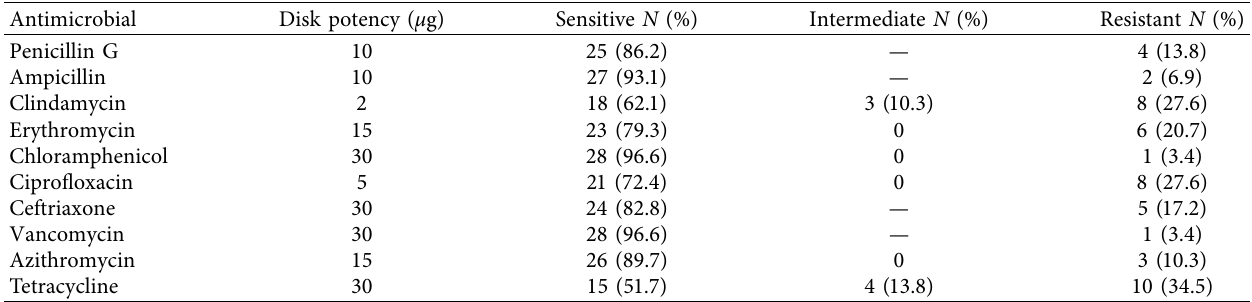
Table 3: Antimicrobial sensitivity profile of GBS isolated from pregnant women at JJUSSHYRH and KGH in Jigjiga city, Southeast Ethiopia, March–May,